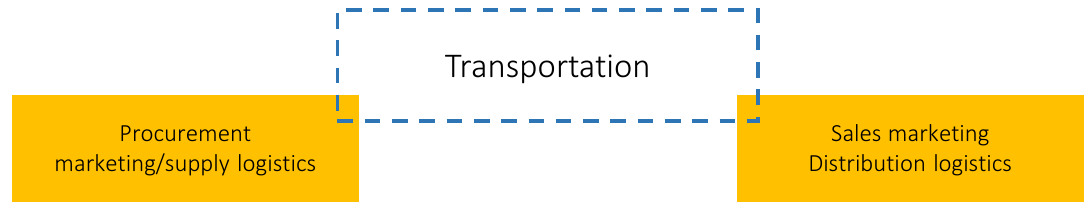
Source: Developed by the first